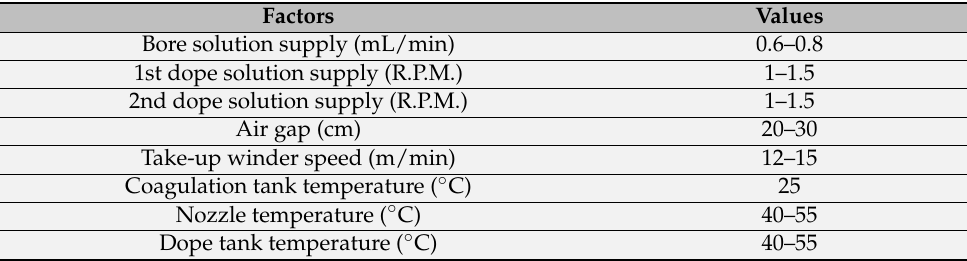
Table 2. HF membrane fabrication spinning